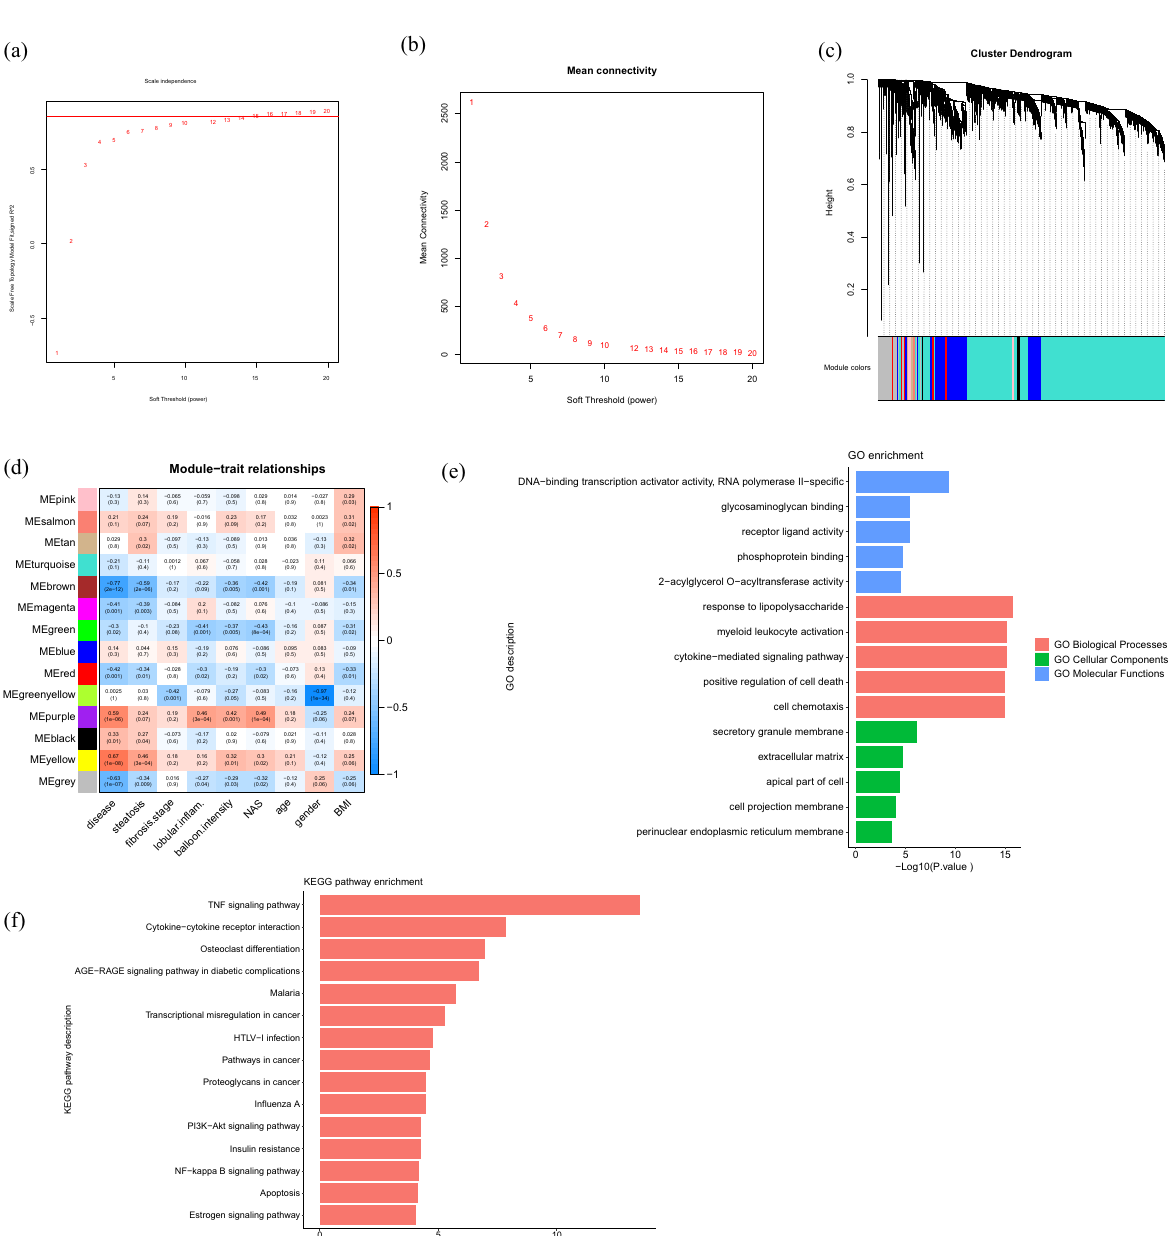
samples with NASH than in healthy controls ( p - value < 0.01 ) . The expression of NAMPT, RALGDS, GADD45B, FOSL2, RASD1, and RTP3 did not statistically di ff er between